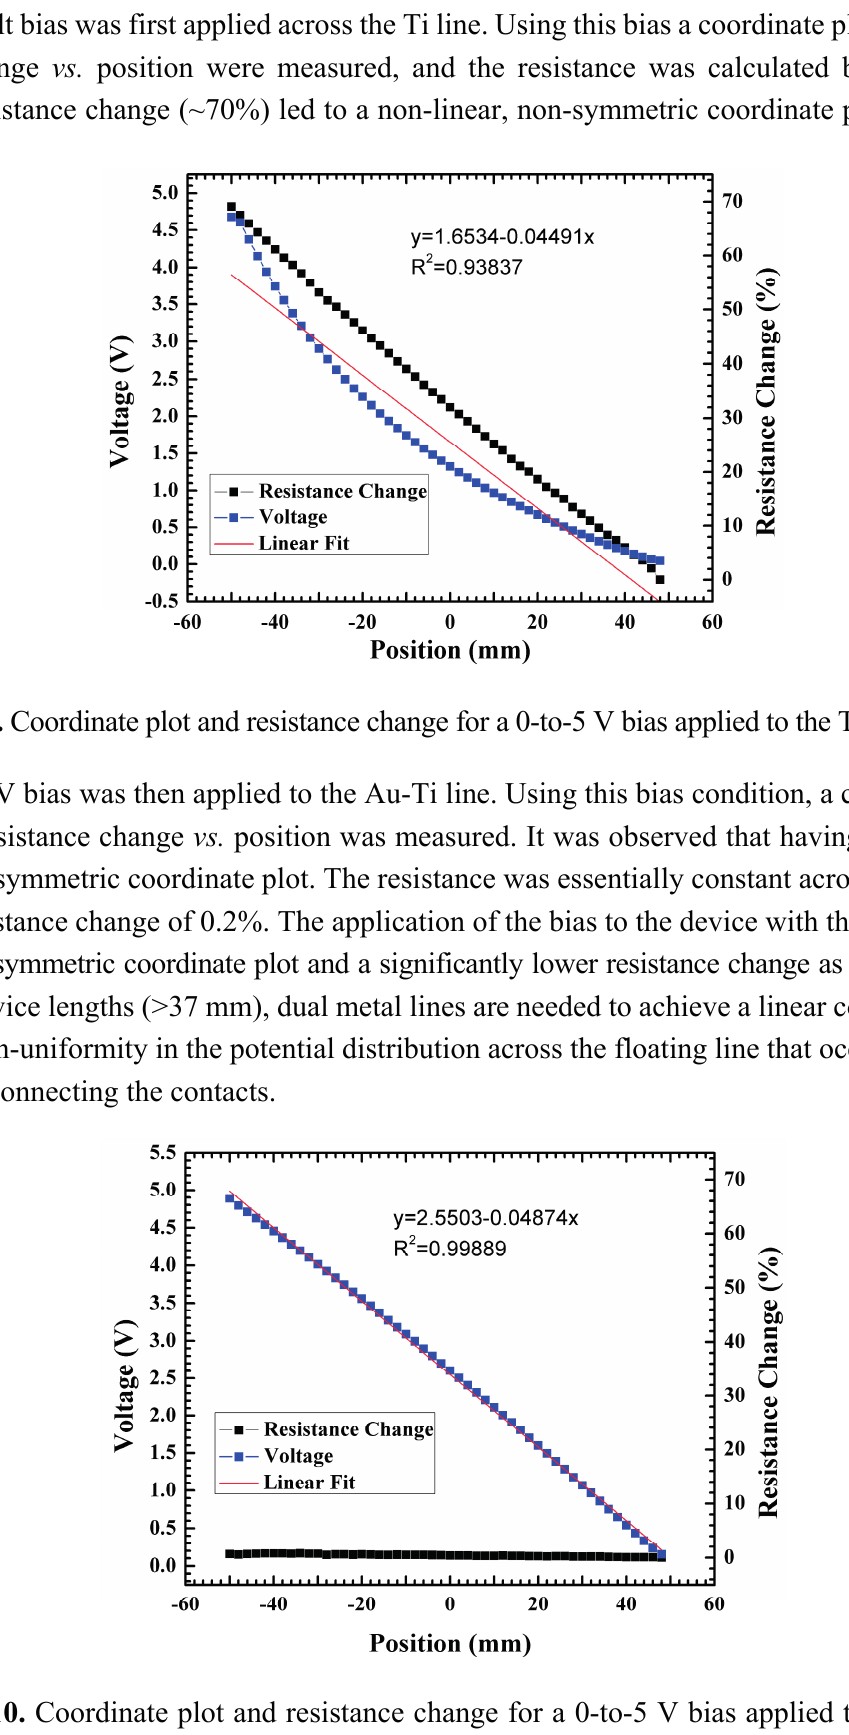
Figure 10. Coordinate plot and resistance change for a 0-to-5 V bias applied to the Ti/Au metal